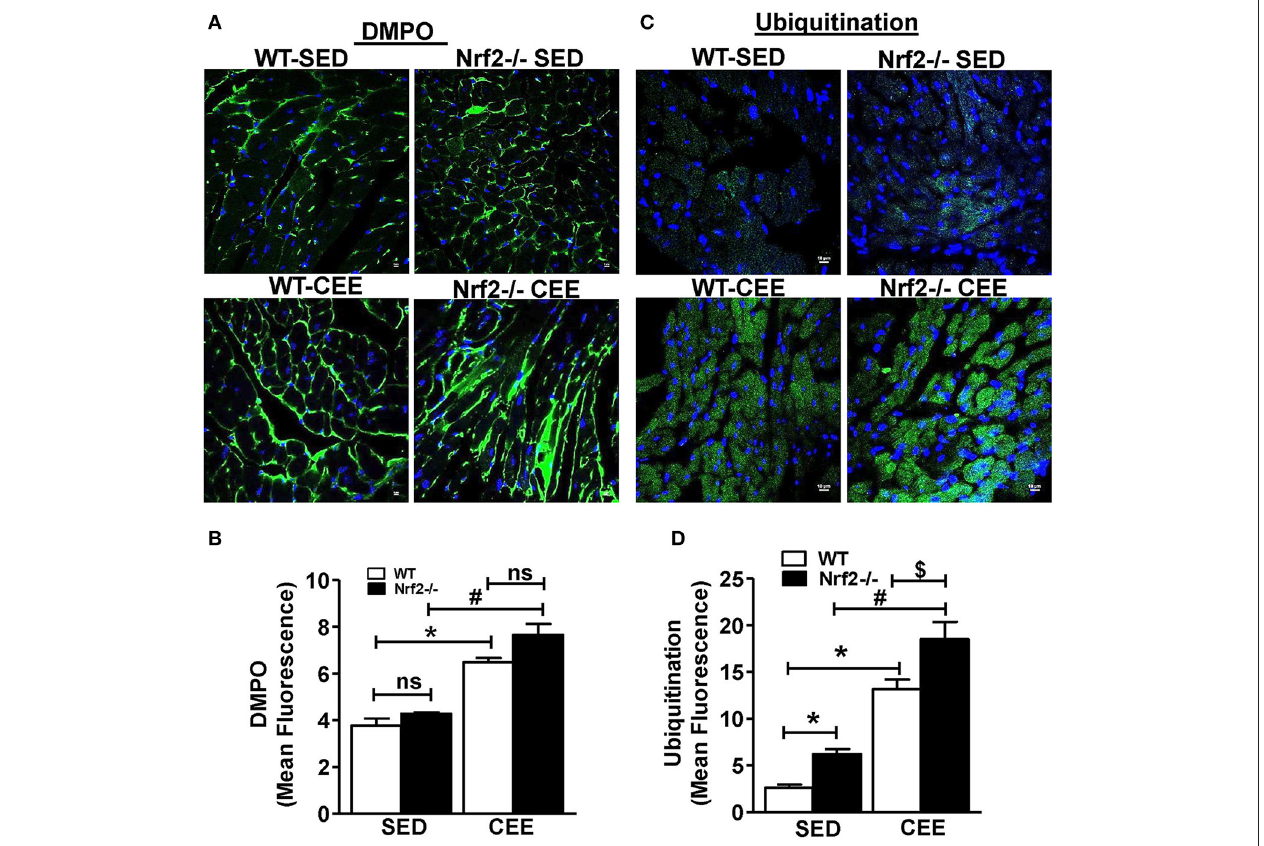
FIGURE 4 | Chronic endurance exercise induces pronounced oxidative stress and accumulation of ubiquitinated proteins in Nrf2 − / − mice: DMPO was injected to sedentary and exercised mice 2h prior to sacrifice. Cryo-sections from hearts of WT and Nrf2 − / − mice were fixed with paraformaldehyde and processed for detecting the (A,B) DMPO–protein radical-derived nitrone adducts and (C,D) ubiquitin protein conjugates by immunostaining with anti-DMPO and anti-ubiquitin antibodies respectively. The fluorescent images were captured at 60X magnification using confocal microscopy, DAPI staining shows nucleus in blue color. Fluorescence intensity was measured using ImageJ software and the mean fluorescence intensity was represented as mean ± SD , n = 4/group. Experiments were analyzed using one way ANOVA followed by Tukey multiple comparison tests and differences between the means were considered statistically significant if P < 0.05 (* vs. WT-SED, # vs. Nrf2 − / − -SED, $ vs. WT